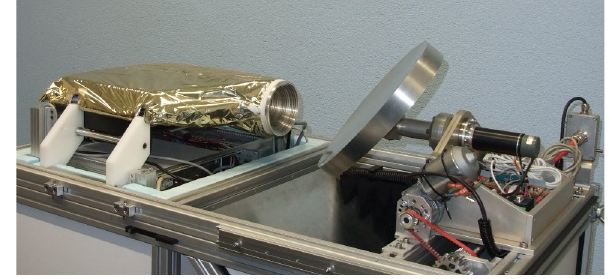
Table 1. Key parameters and specifications of